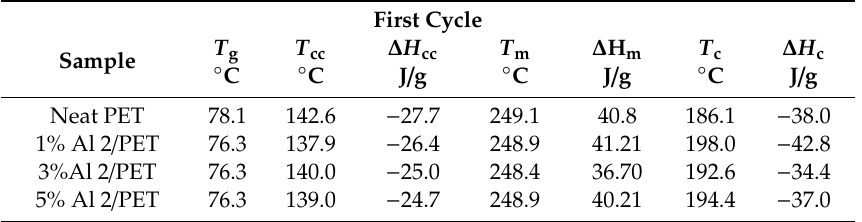
Figure 9. Thermograms of the first DSC heating-cooling cycle of PET and nano-Al 2 / PET composites. Table 5. Thermal parameters obtained from the first cycle of DSC thermographs of neat amorphous PET and nano Al 2 / amorphous PET